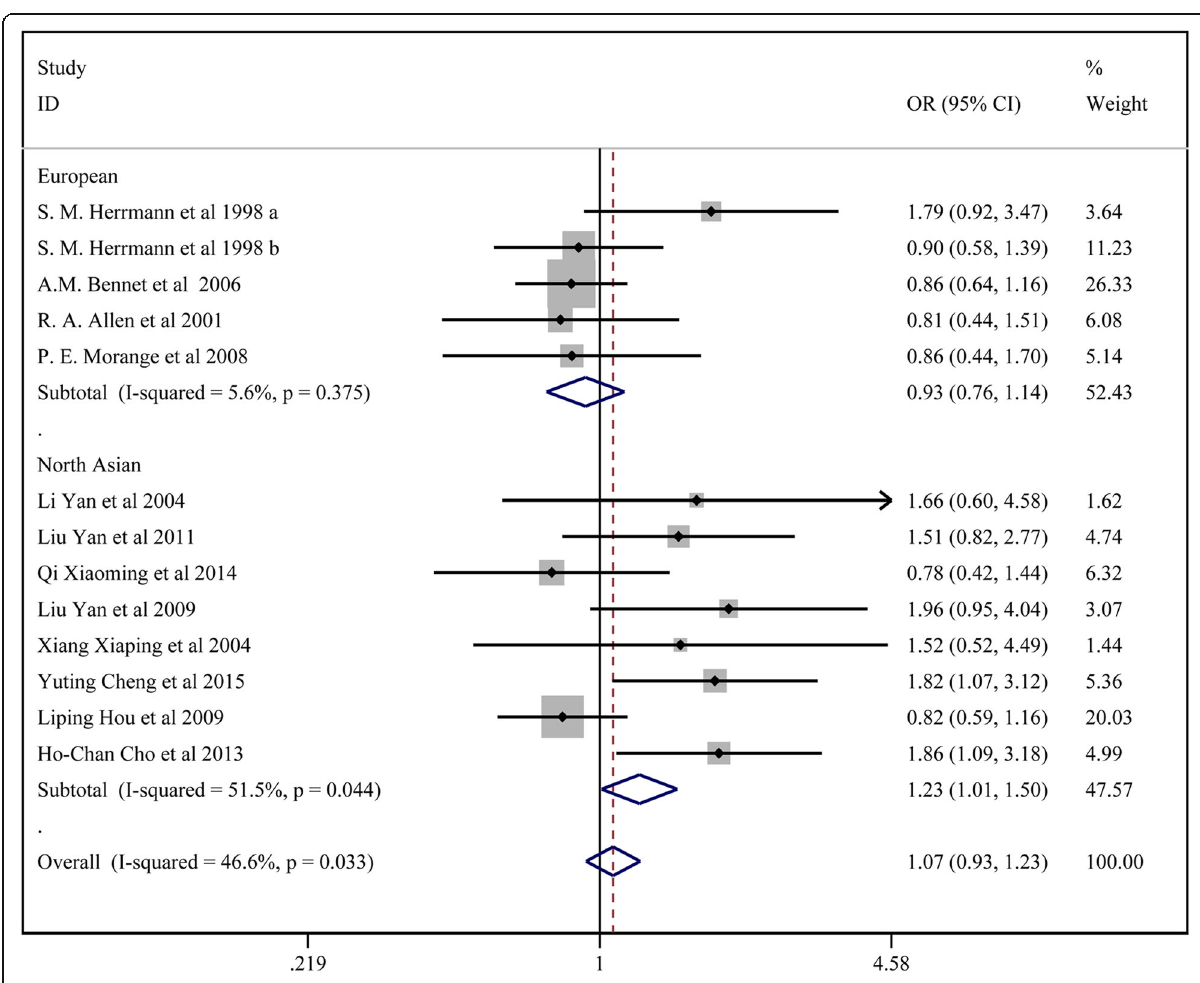
Fig. 5 Forest plot for the dominant model of TNF- α 238G/A polymorphisms associated with